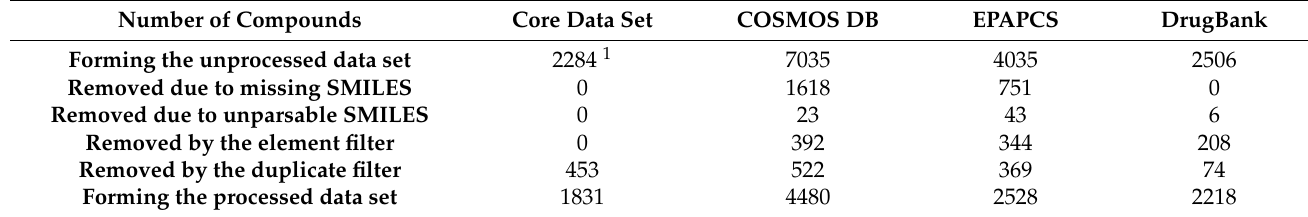
Table 8. Number of molecules removed during each processing